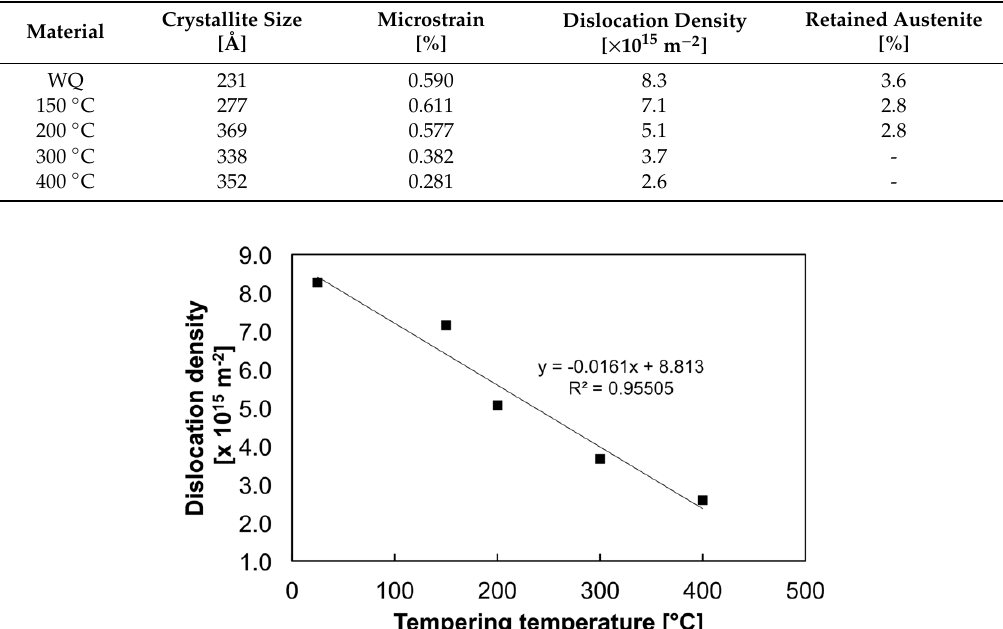
Table 2. Microstrain, crystallite size, dislocation density, and retained austenite content based on the X-Ray diffraction (XRD) measurements.